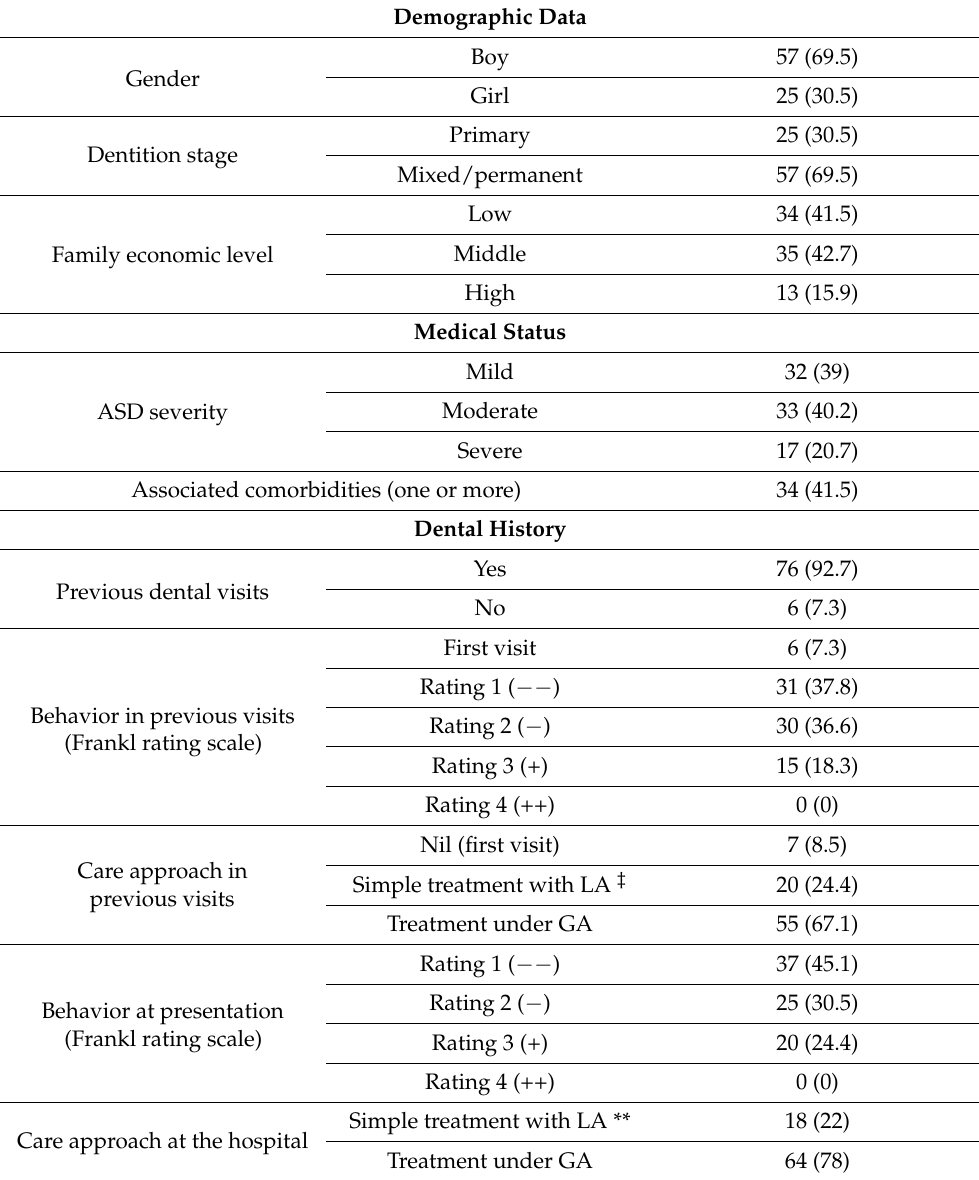
Table 1. Characteristics of ASD children ( n = 82, n